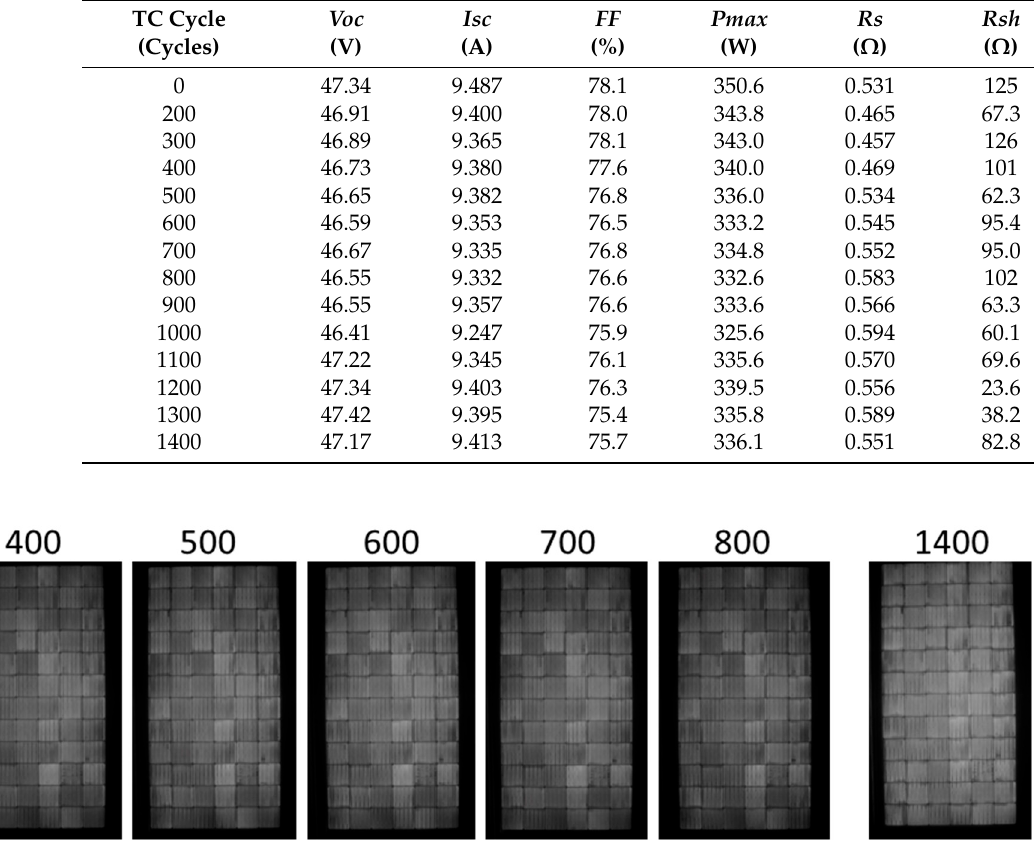
Figure 7. Electroluminescence images of modules with respect to temperature cycles.